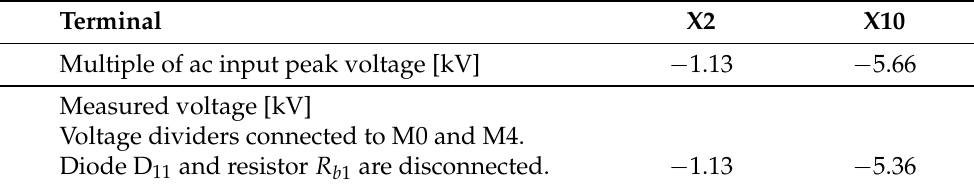
Figure 3. Schematic diagram of the measurement setup. The voltage divider elements nominal values are: R 0 = R 1 = R 2 = R 3 = 40 M Ω , R d 0 = R d 1 = R d 2 = R d 3 = 11 k Ω , C d 0 = C d 1 = C d 2 = C d 3 = 20 µ F. Table 1. Comparison between calculated and measured magnitude of the dc voltage at terminals X2 and X10 of the circuit shown in Figure 2, having as load only voltage dividers, for the ac voltage applied to the input X0, U i = 400 V rms